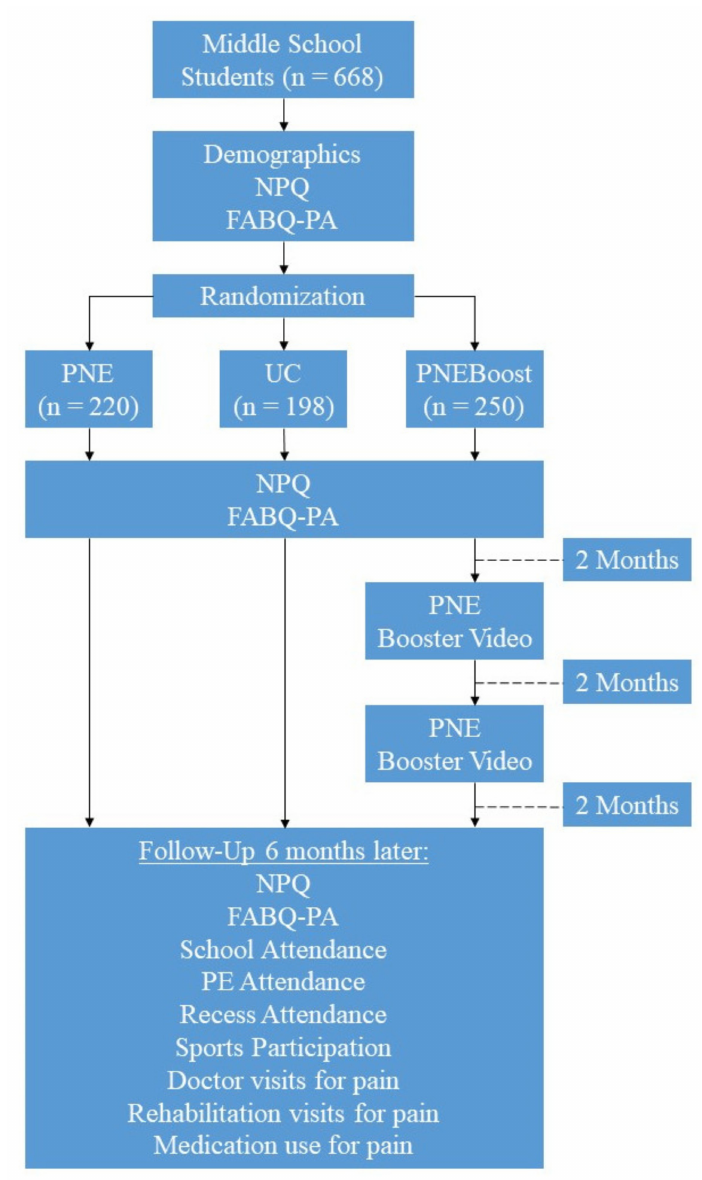
Figure 1. Study Flow